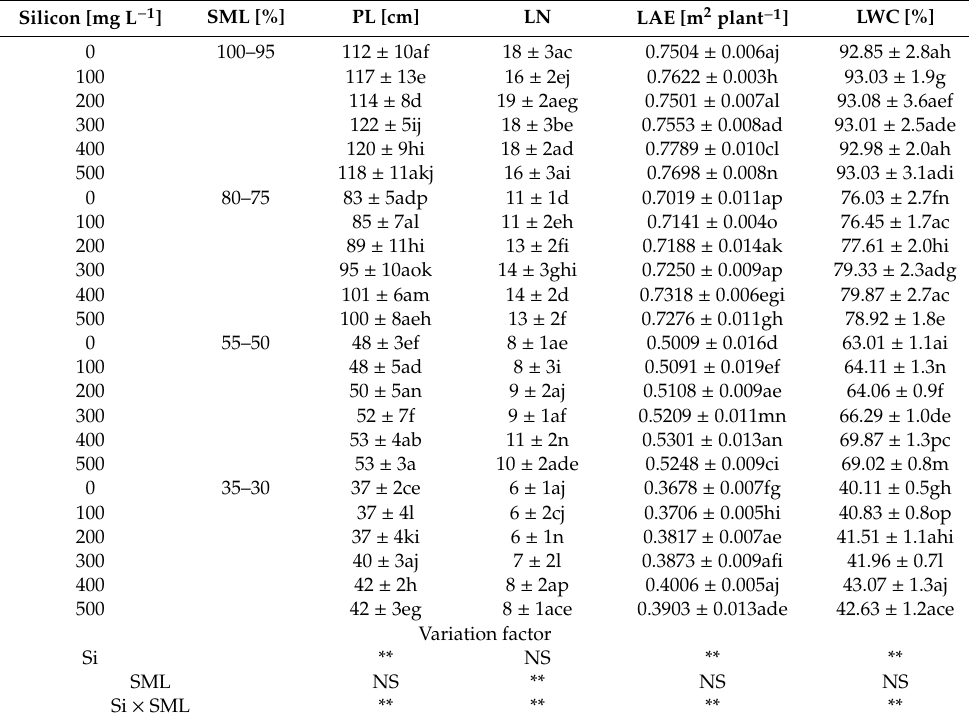
Table 1. E ff ect of silicon (0, 100, 200, 300, 400 and 500 mg Si L − 1 ) on plant length (PL), Leaf number (LN), leaf area-expansion (LAE), and leaf water content (LWC) in sugarcane plants exposed to 100–95, 80–75, 55–50 and 35–30% of soil moisture (SM). Data are means ± SE ( n =